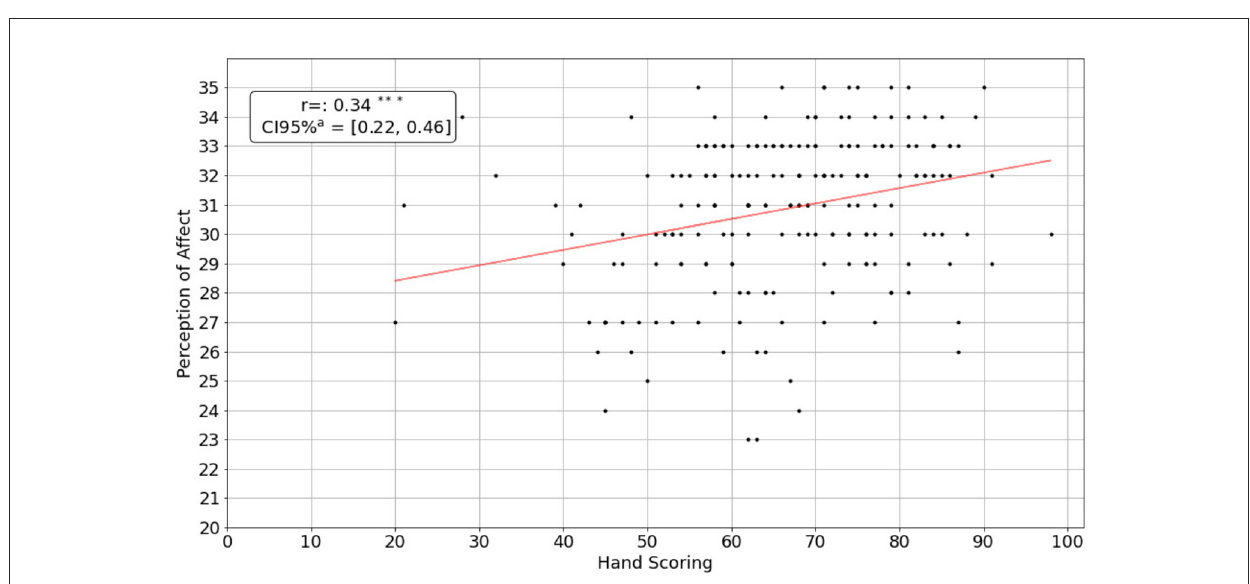
FIGURE3 Correlation between 3345plus scores and the perception of emotions represented by facial expressions. ∗ P ≤ 0.05, ∗∗ P ≤ 0.01, ∗∗∗ P ≤